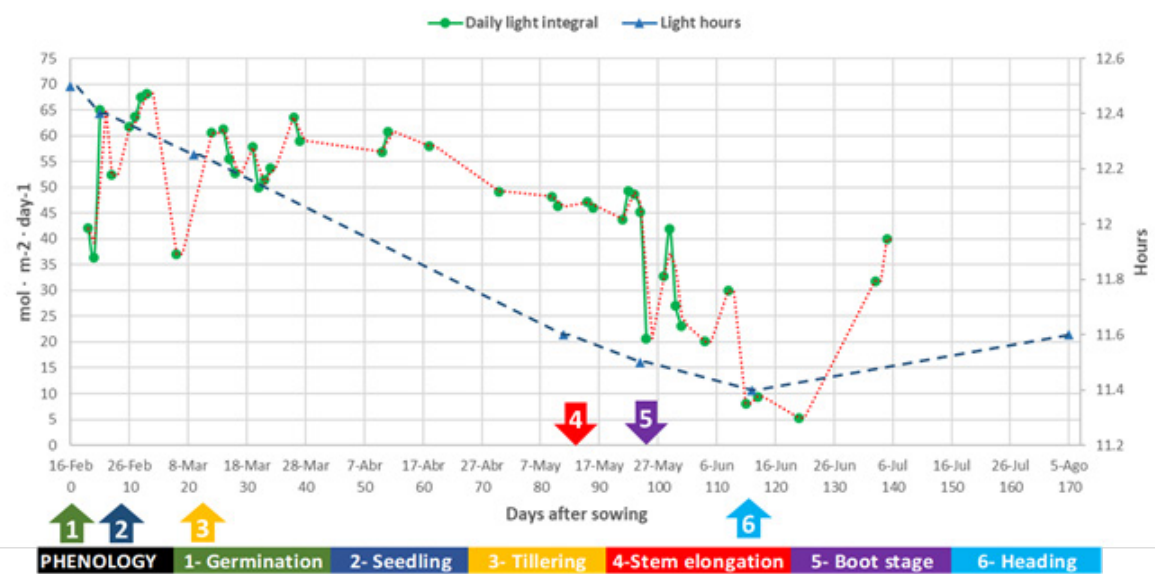
Figure 13 . Fluctuation of the Photosynthetic Active Radiation-PAR, expressed as the Daily Light Integral ( mol∙m -2∙ day -1 ) and Light hours during the field stage of the